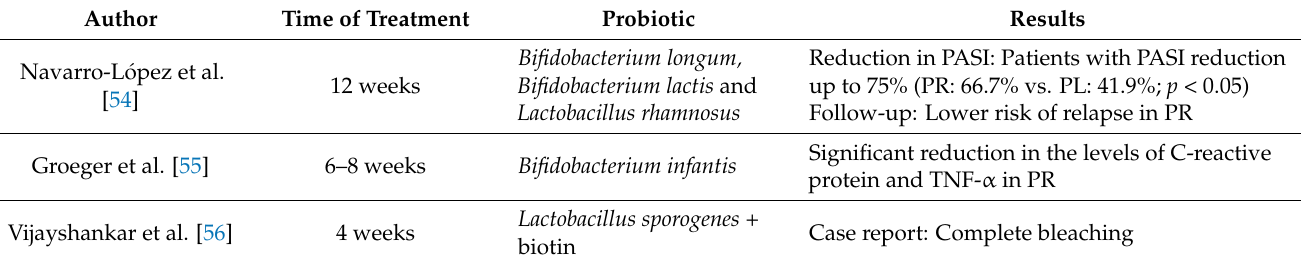
Table 3. Probiotics and